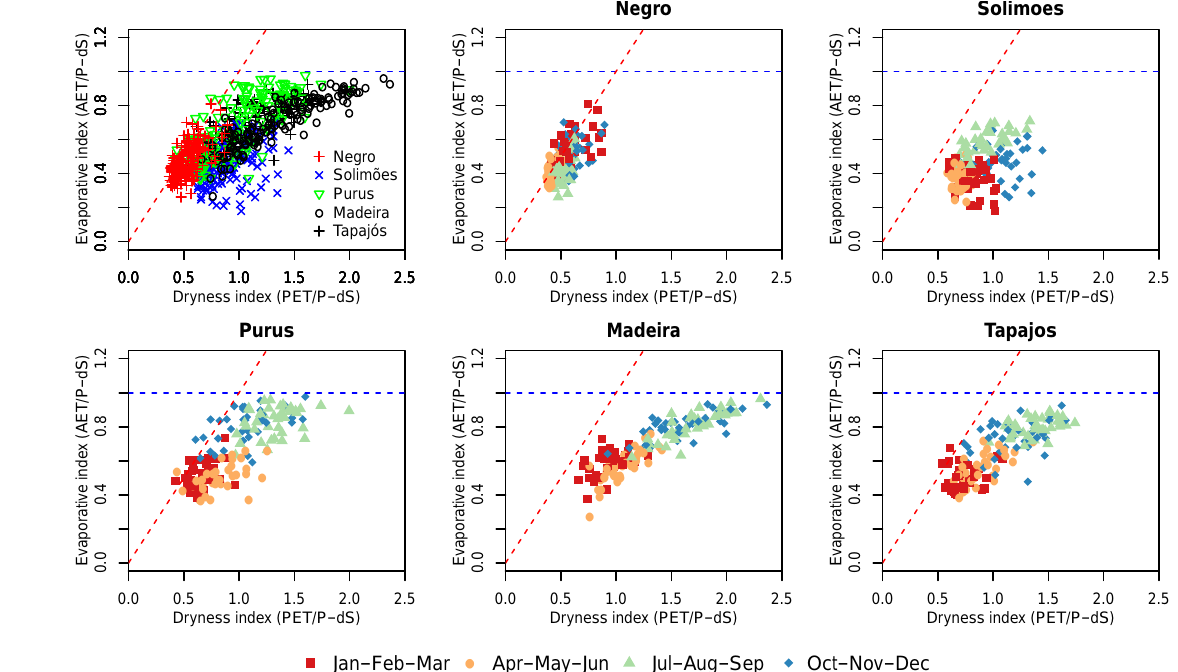
Figure 4. Modified Budyko analysis for monthly water balance values. The red dashed line represents the energy limitation threshold, above which ET is limited by solar radiation. The blue dashed line represents the water limitation threshold.